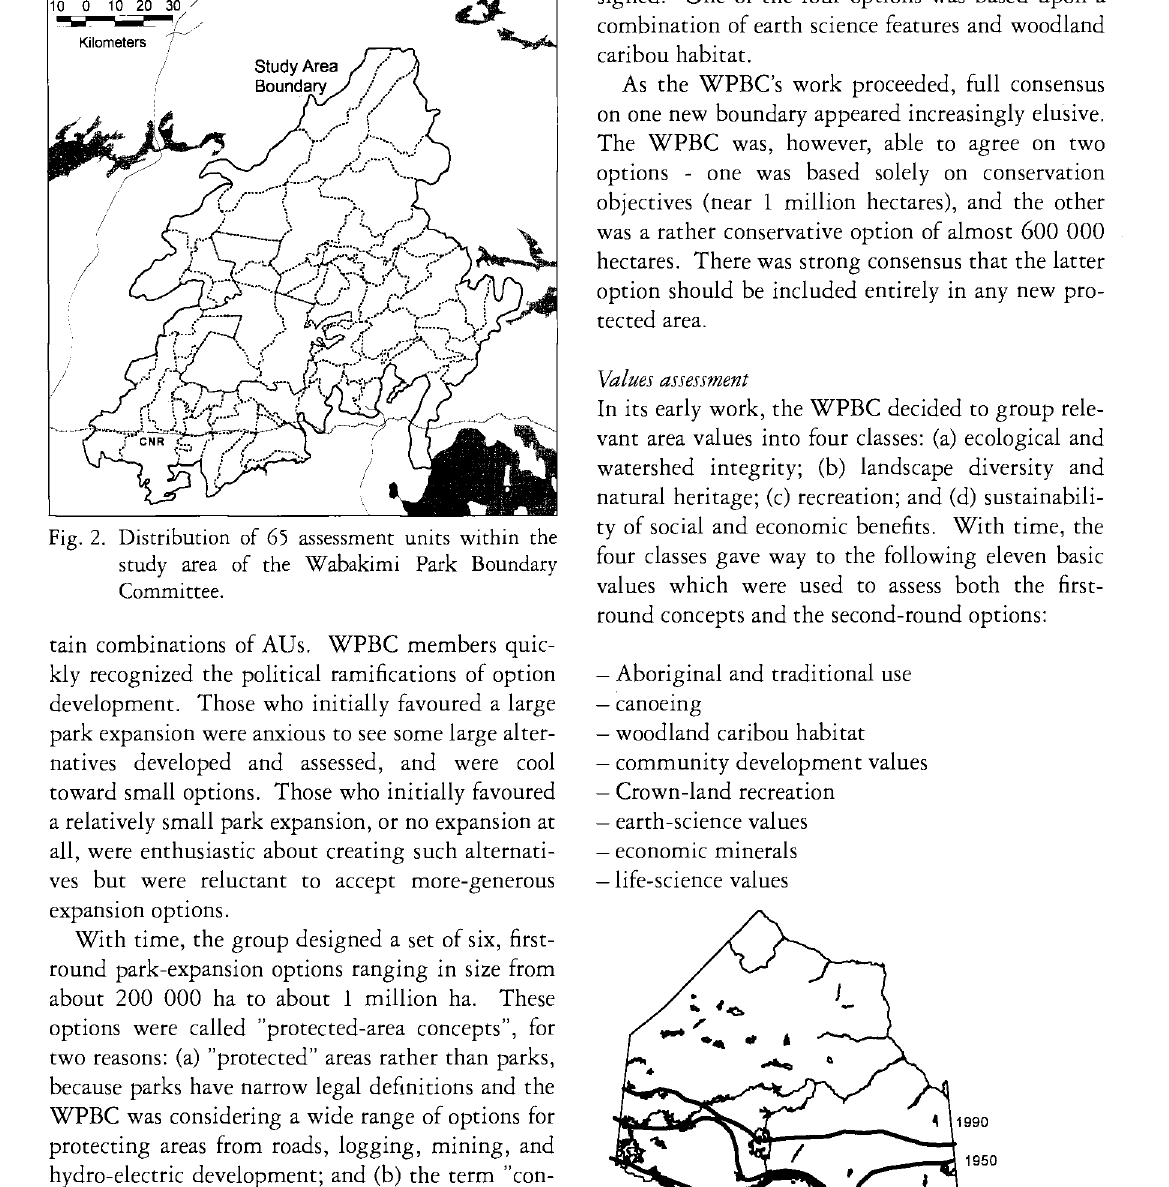
Fig. 3. Recession of the southern limit of continuous dis tribution of woodland caribou in Ontario since 1880 (source: Cumming & Beange,